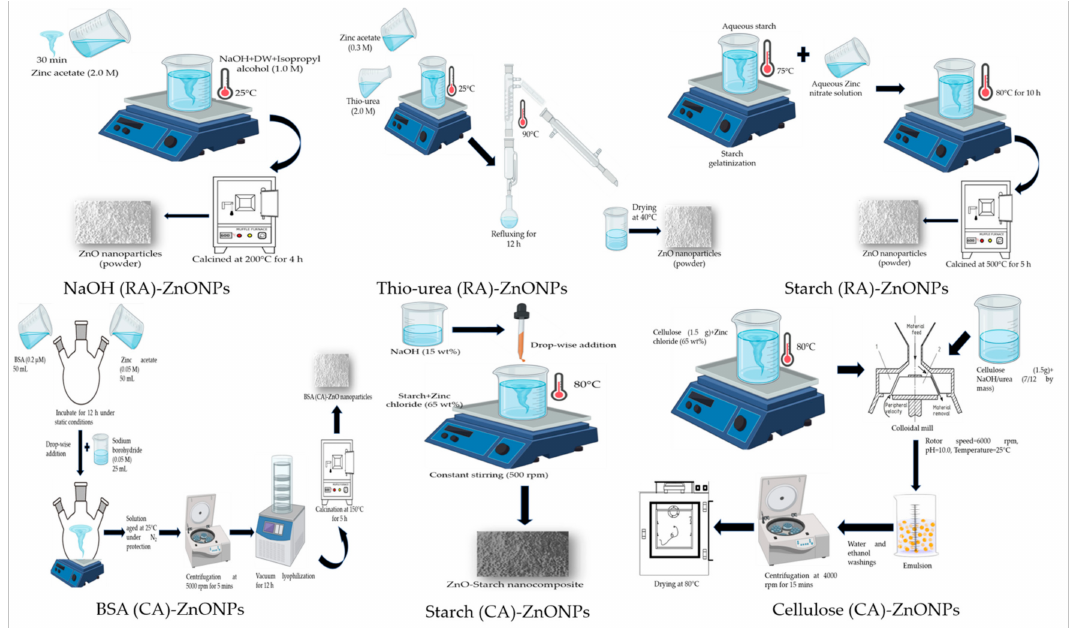
Figure 1. Schematic representation of steps for the synthesis of zinc nanomaterials using different reducing and complex- ing/capping